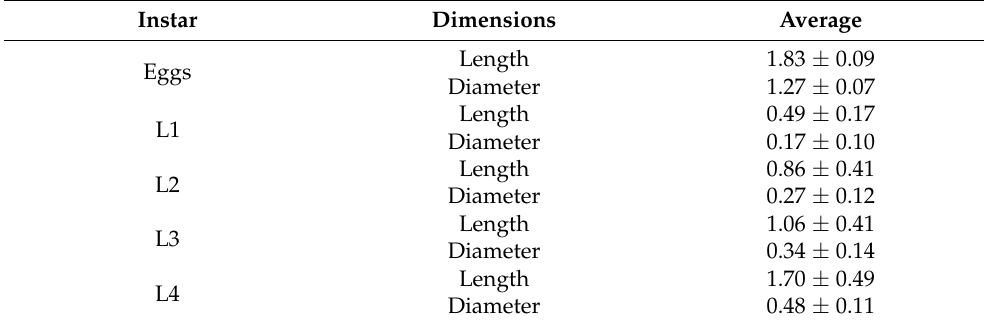
Figure 9. Dimensional increase (in cm) of Aclees taiwanensis larvae over time (days) under laboratory conditions. Dotted lines represent linear regressions. Bars represent standard deviations. Table 4. Aclees taiwanensis preimaginal instar dimensions measured after 24 h from the oviposition or after the moult.